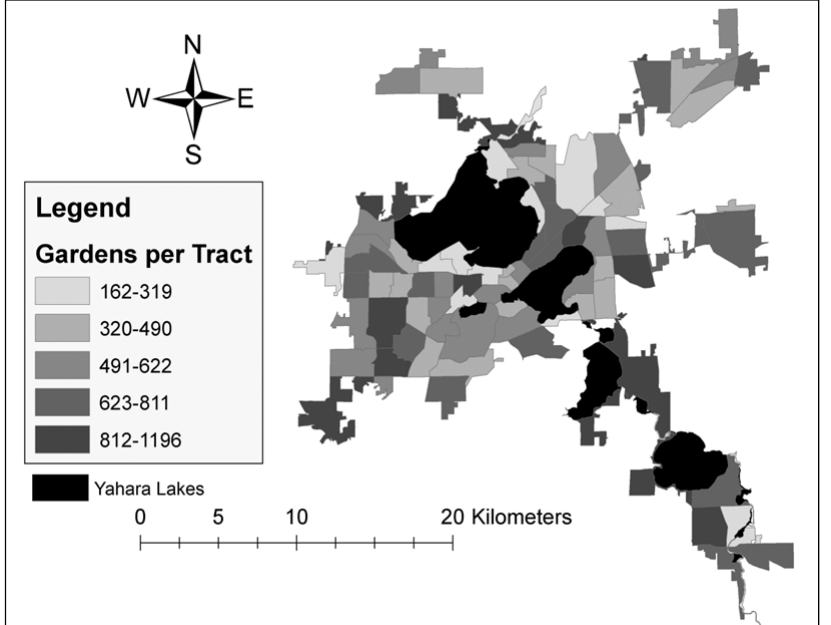
Figure 7. Estimated Number of Home Gardens by Census Tract Garden presence increases as distance from urban center and median household income increase.